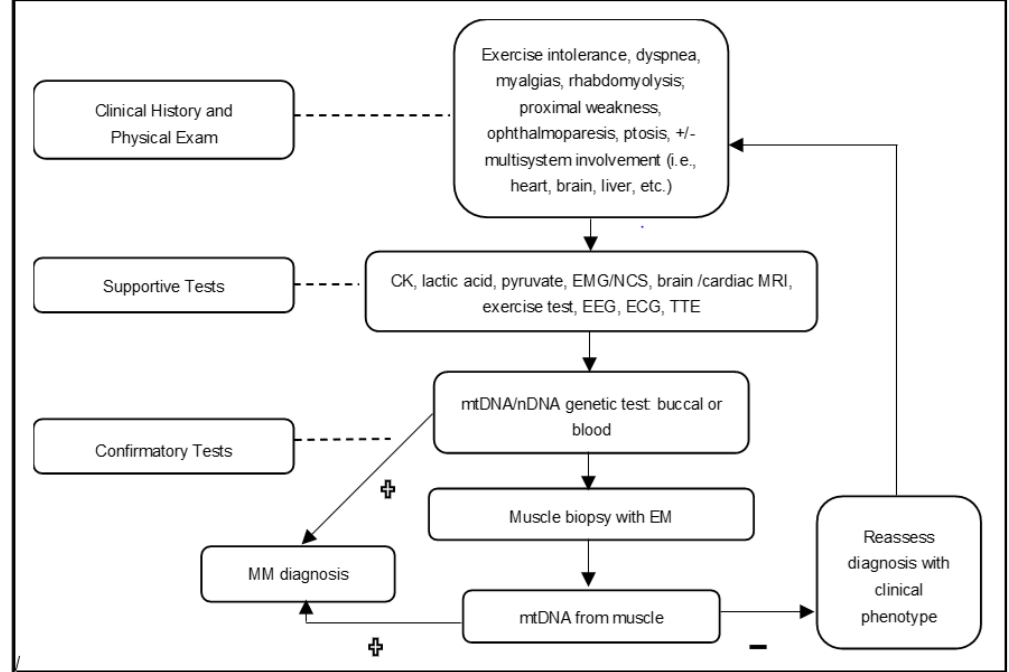
Figure 1. Diagnostic template that may be used when treating suspected PMM. CK: creatine kinase, EMG/NCS: electromyogram and nerve conduction study, MRI: magnetic resonance imaging, EEG: electroencephalogram, ECG: electrocardiogram, TTE: transthoracic echocardiogram, and EM: electron microscopy.